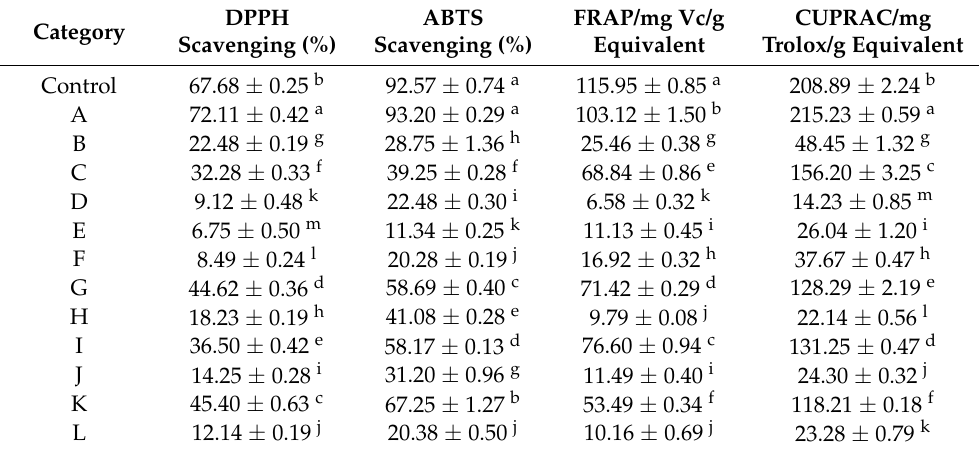
Table 2. The antioxidant activity of DPPH, ABTS, FRAP, and CUPRAC of seven plant materials of the Polygonaceae family and grape